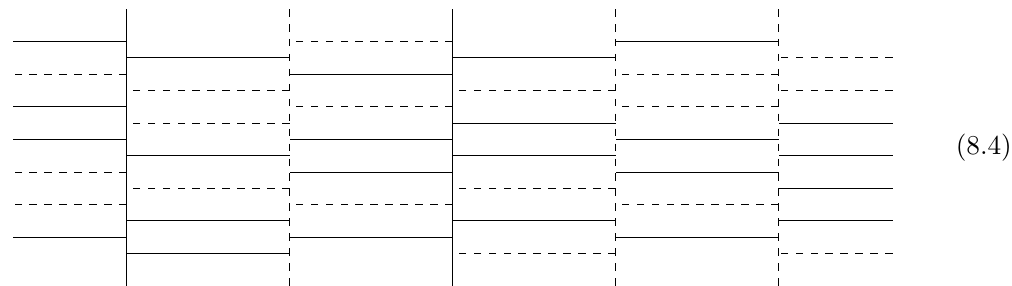
while the dashed v .The module with level ( − 1 , 0) u